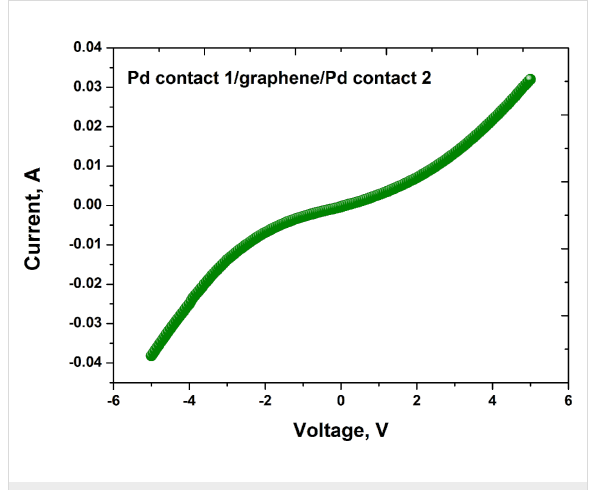
Figure 4: The typical I – V curve, which describes the voltage and the current flowing through the graphene channel between two palladium